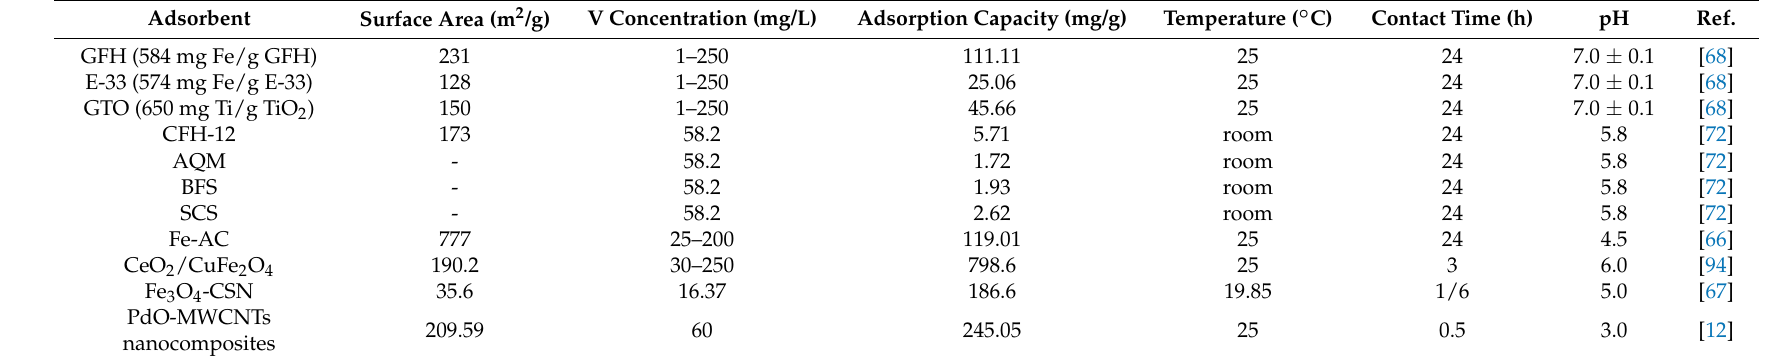
Table 3. Sorption properties of metal oxide-based adsorbents for vanadium oxyanions